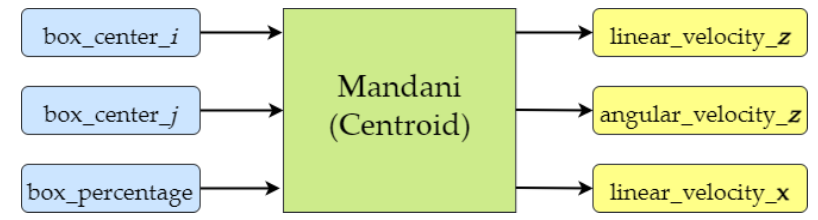
Figure 10. Inputs and output of the fuzzy controller.